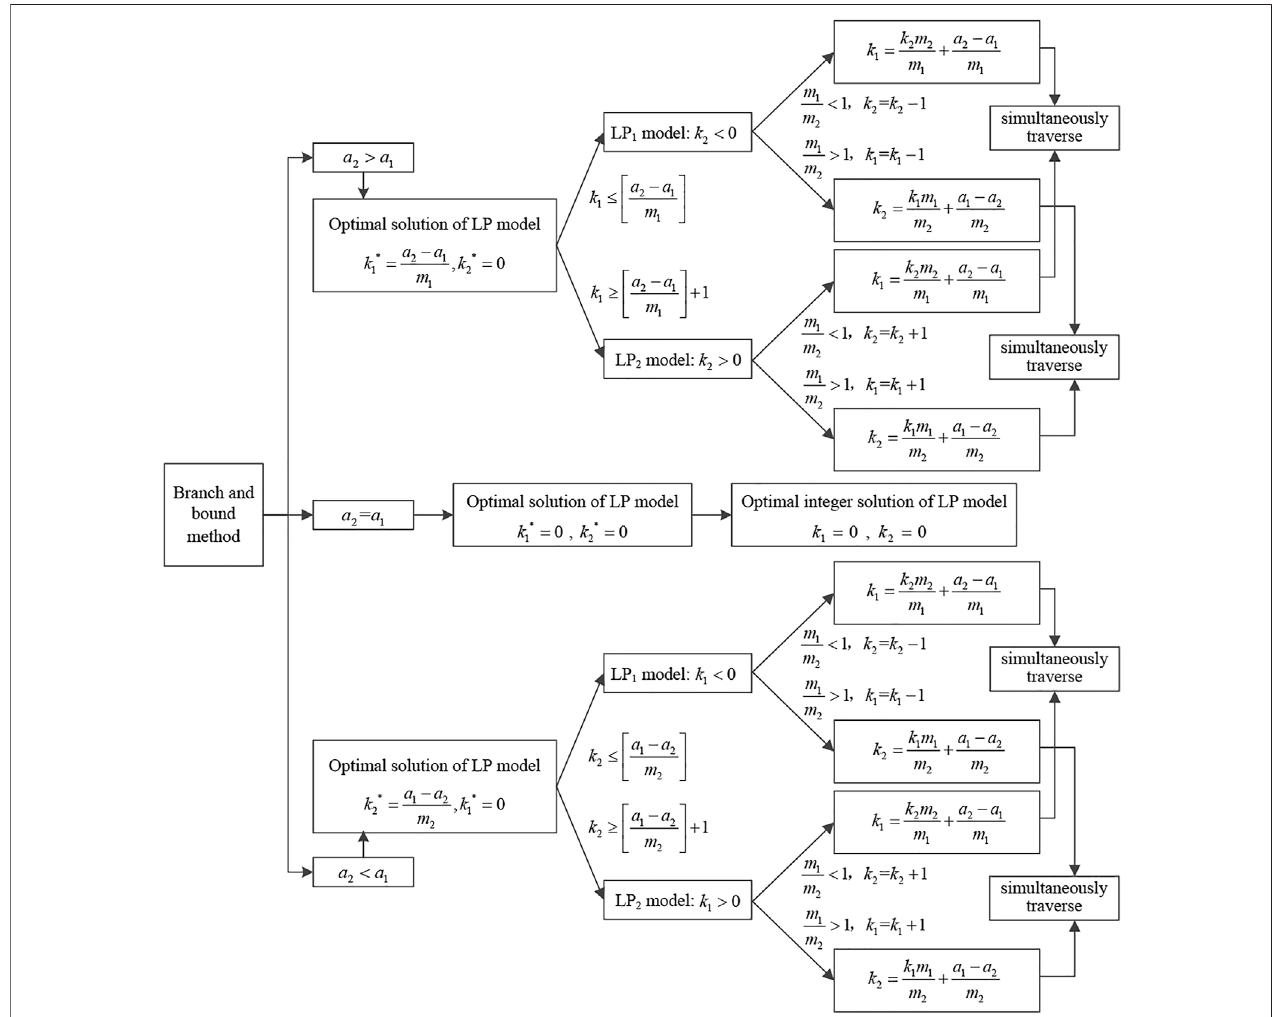
FIGURE 3 | Solution process of branch and bound PIP – PU algorithm for dual-baseline InSAR.